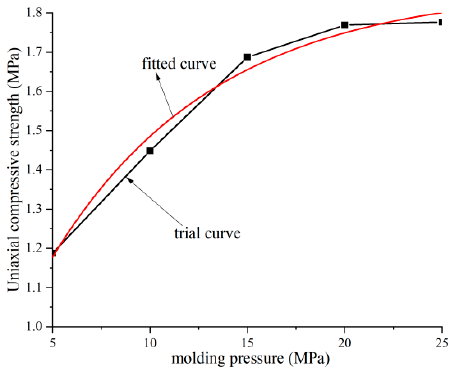
Figure 10. Effects of the molding pressure on strength.